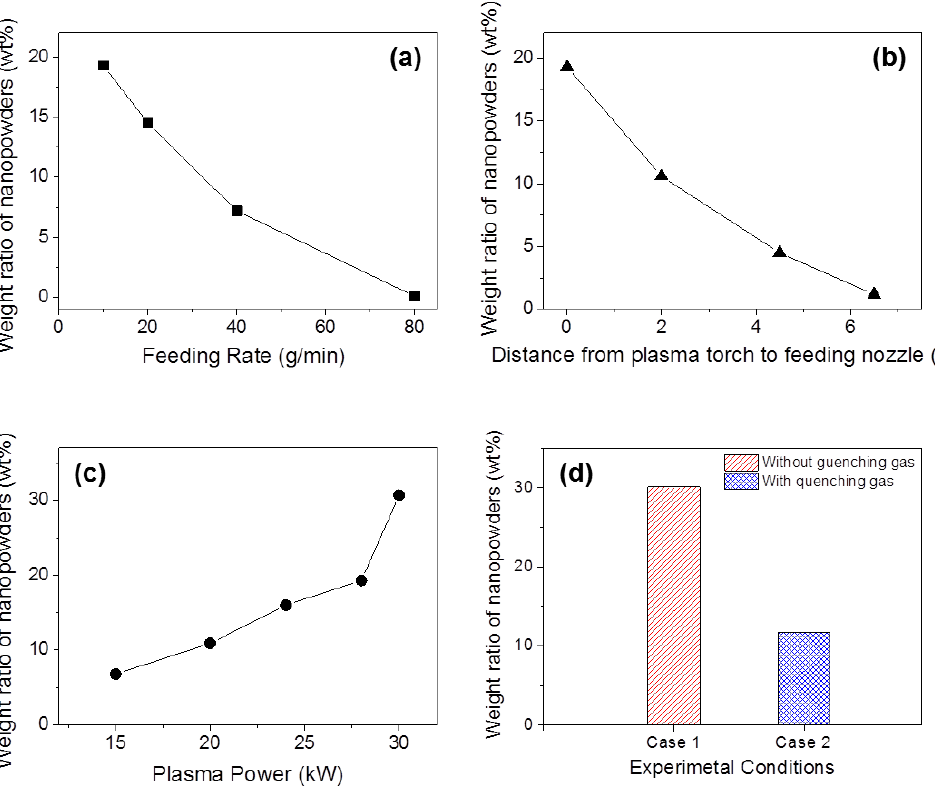
Figure 5. Weight ratio of stainless steel 316L nano-powders with respect to various experimental variables, i.e. , ( a ) feeding rate, ( b ) distance from the plasma torch to the feeding nozzle, ( c ) plasma powder and ( d ) quenching effect, after RF plasma